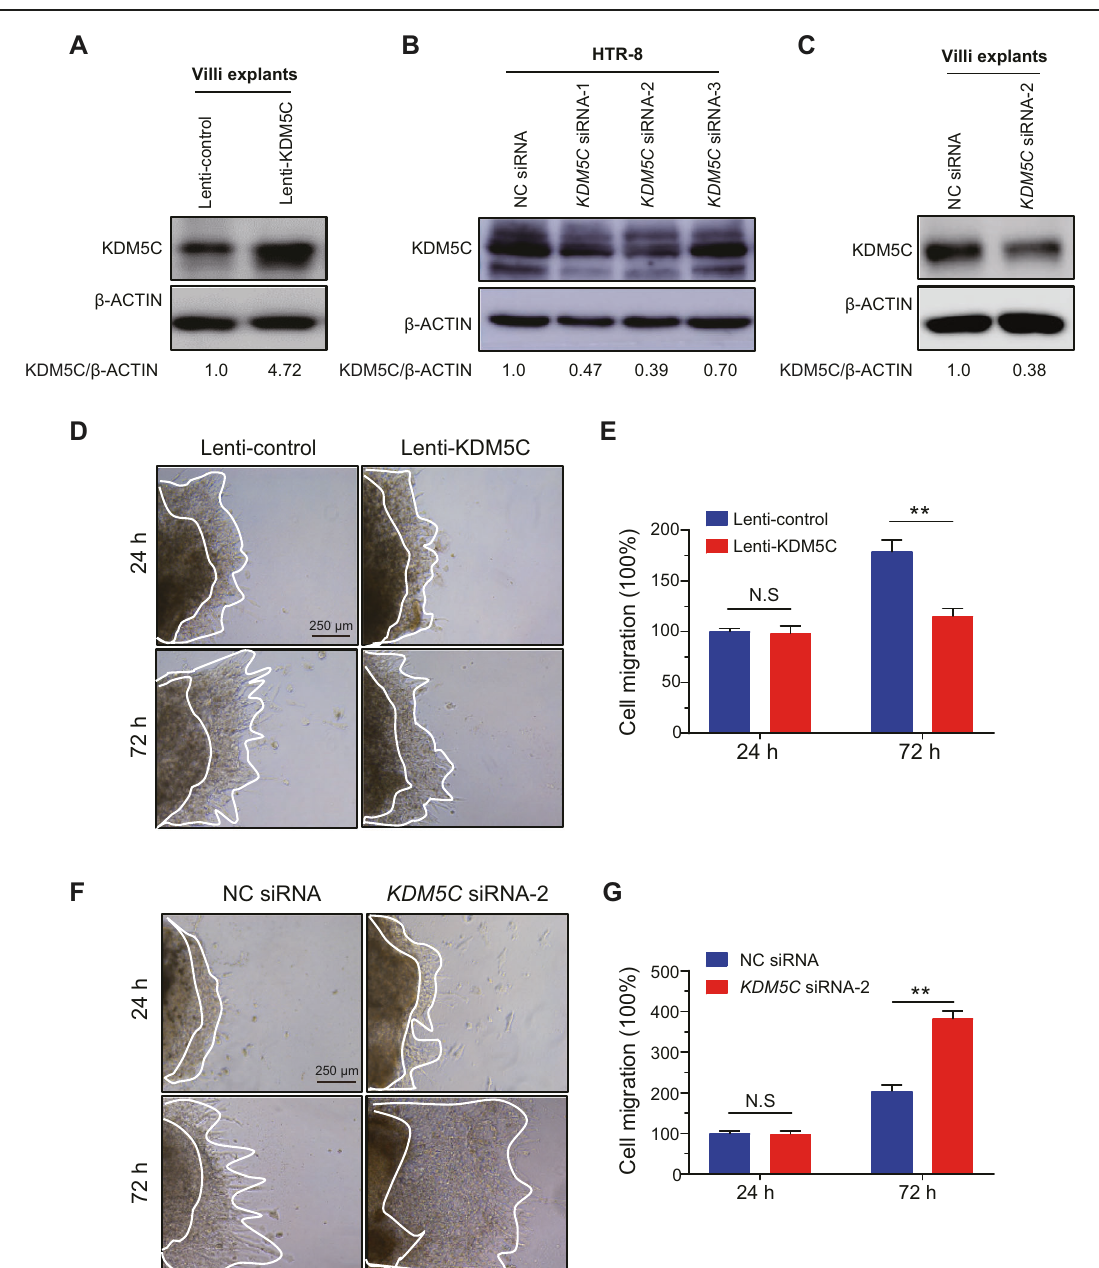
Fig. 3 KDM5C inhibits trophoblast outgrowth in a villi explants model. A The villi explants were seeded in Matrigel-coated plates, and western blotting assay was performed on KDM5C protein from explants treated with either lenti-control or lenti-KDM5C for 72 h. B Level of KDM5C protein was determined in HTR-8 cells transduced with control or KDM5C siRNAs using western blotting assay. C The villi explants were plated on Matrigel-coated plates, and western blotting assay was performed on KDM5C protein in extravillous explants transduced with either NC siRNA or KDM5C siRNA-2 for 72 h. D , E Villi explants from HCs were cultured on Matrigel-coated plates. Time course images of the villi explants treated with either lenti-control or lentiviral vector carrying the KDM5C gene (lenti-KDM5C) were taken using light microscopy